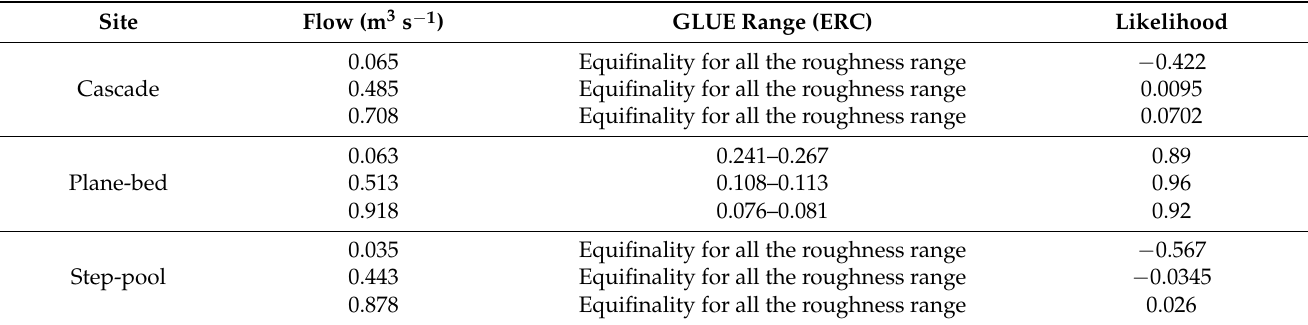
Table 2. Range of values for calibrated n value for Experiment